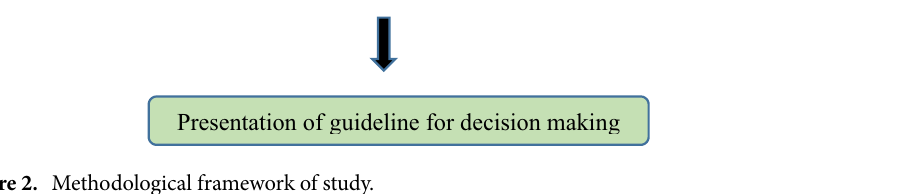
Figure 2. Methodological framework of study.